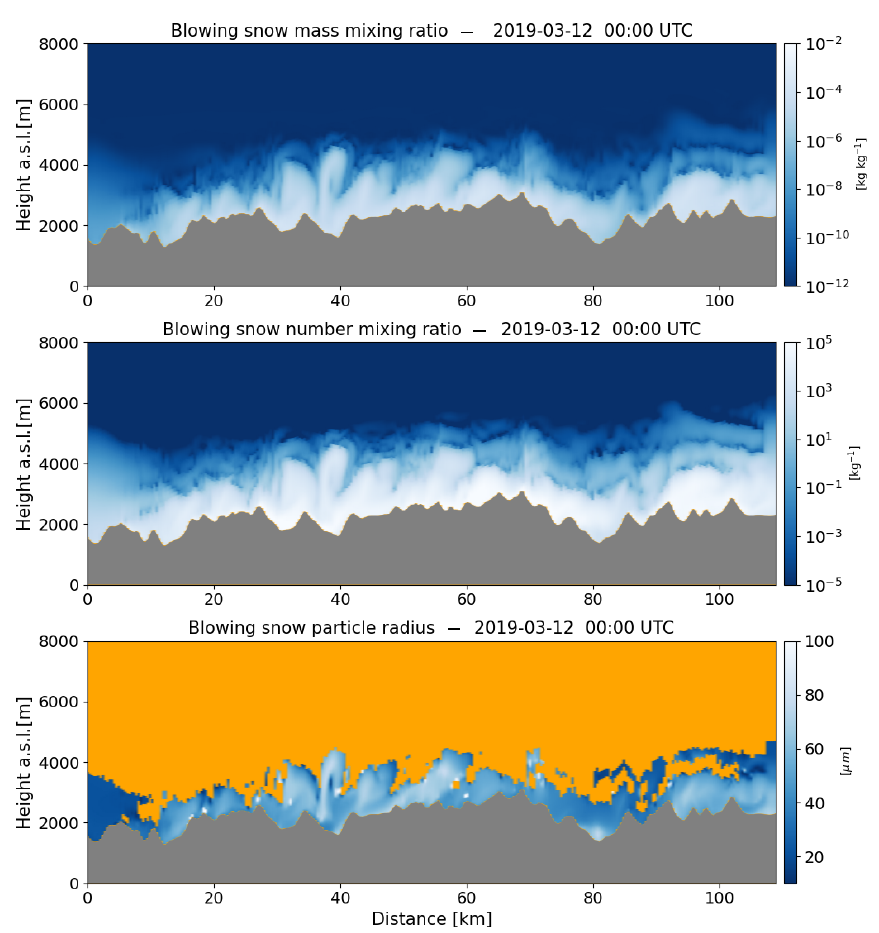
Figure 17. Blowing snow in the atmosphere on 12 March 2019 at 00:00UTC along the transect marked by the dashed red line in Fig. 13c. (a) Blowing snow mixing ratio, (b) number mixing ratio, and (c) particle radii.